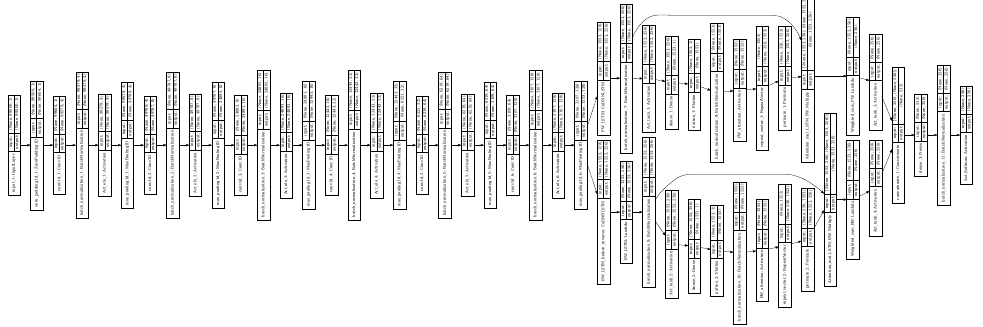
Figure 28: Network for desynchronized ASCAD